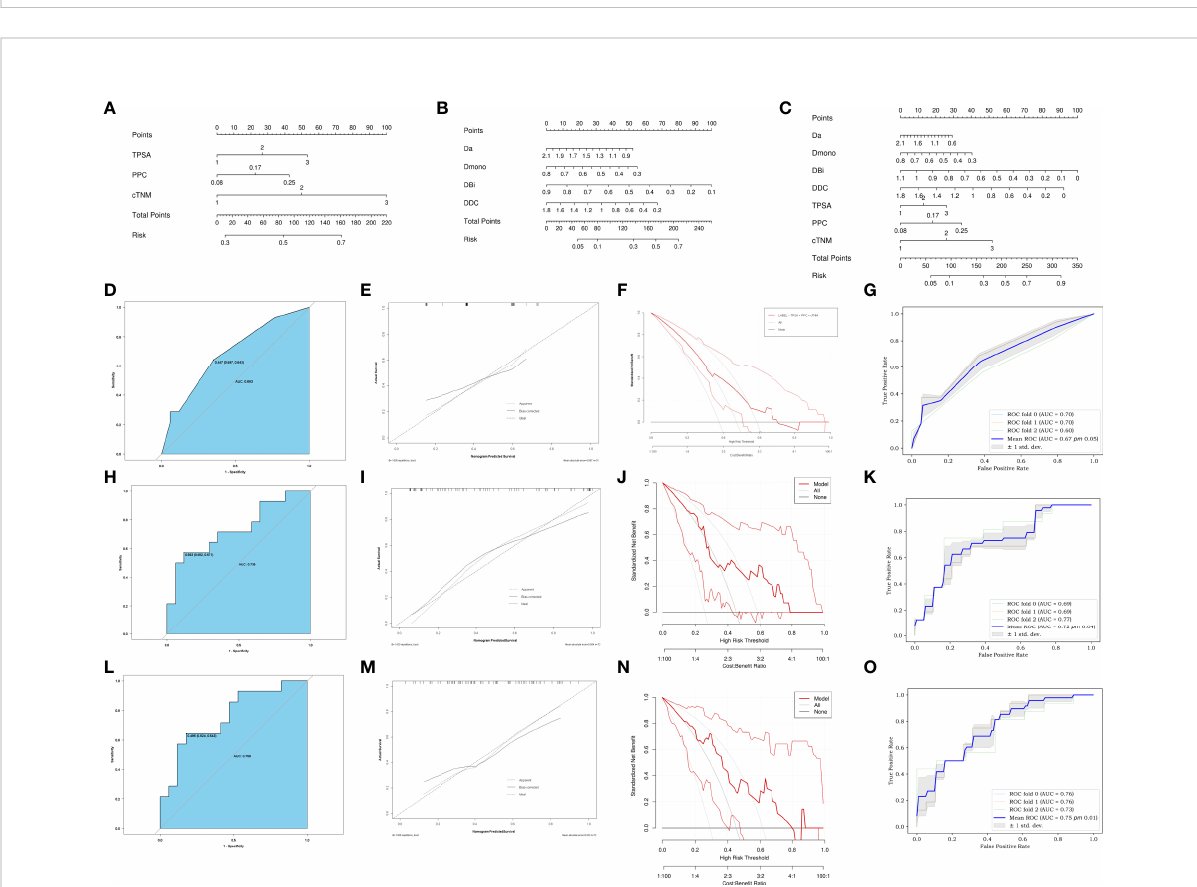
FIGURE 5 Development of C-nomogram (A) , M-nomogram (B) and MC-nomogram (C) predicting PSMs after laparoscopic radical prostatectomy. (D, H, L) ROC validation of the PSMs risk nomogram prediction. The blue area represented the performance of the nomogram. (E, I, M) Calibration curves of the PSMs risk nomogram prediction. The y-axis represents the actual diagnosed PSMs. The x-axis represents the predicted risk of PSMs. The diagonal dotted line represents a perfect prediction by an ideal model. The solid line represented the performance of the C- nomogram (D) , M-nomogram (H) and MC-nomogram (L) , which indicated that a closer fi t to the diagonal dotted line represented a better prediction. (F, J, N) Decision curve of the PSMs risk nomogram prediction. The y axis represents the net bene fi t and the x axis represents the risk threshold. The thick solid line represents the assumption that all patients had no PSMs. The thin solid line represents the assumption that all patients had PSMs. The red line represents the risk nomogram. (F) From C-nomogram, (J) the M-nomogram and (N) MC-nomogram. The net bene fi t of the MC-nomogram is highest in the range from 0.2-0.7.). (G, K, O) Mean ROC curve of the nomogram to predict PSMs after 3-fold cross-validation. TPSA, total prostate speci fi c antigen; PPC, percent of positive